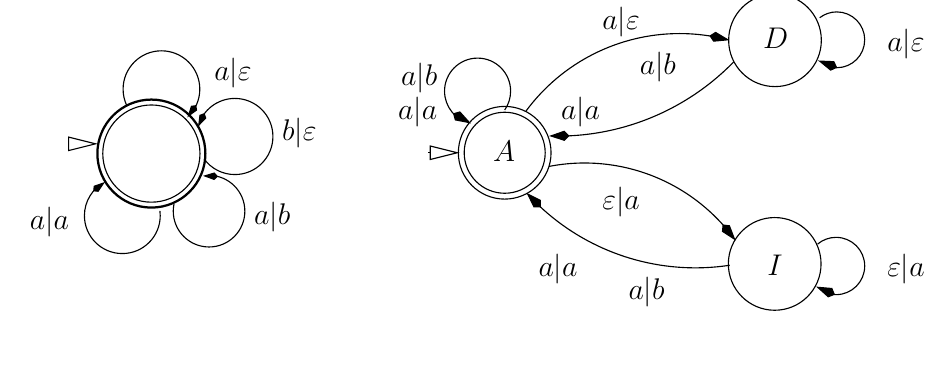
Figure 13. Transducers for edit string distance: simple edit distance (left) and edit